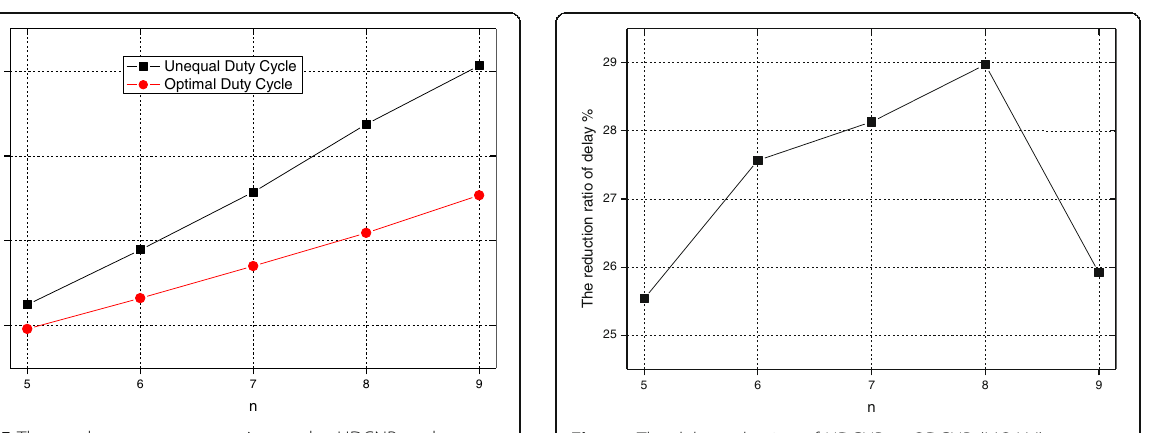
Fig. 17 The delay reduction of UDCNP vs ODCNP (MQAM)